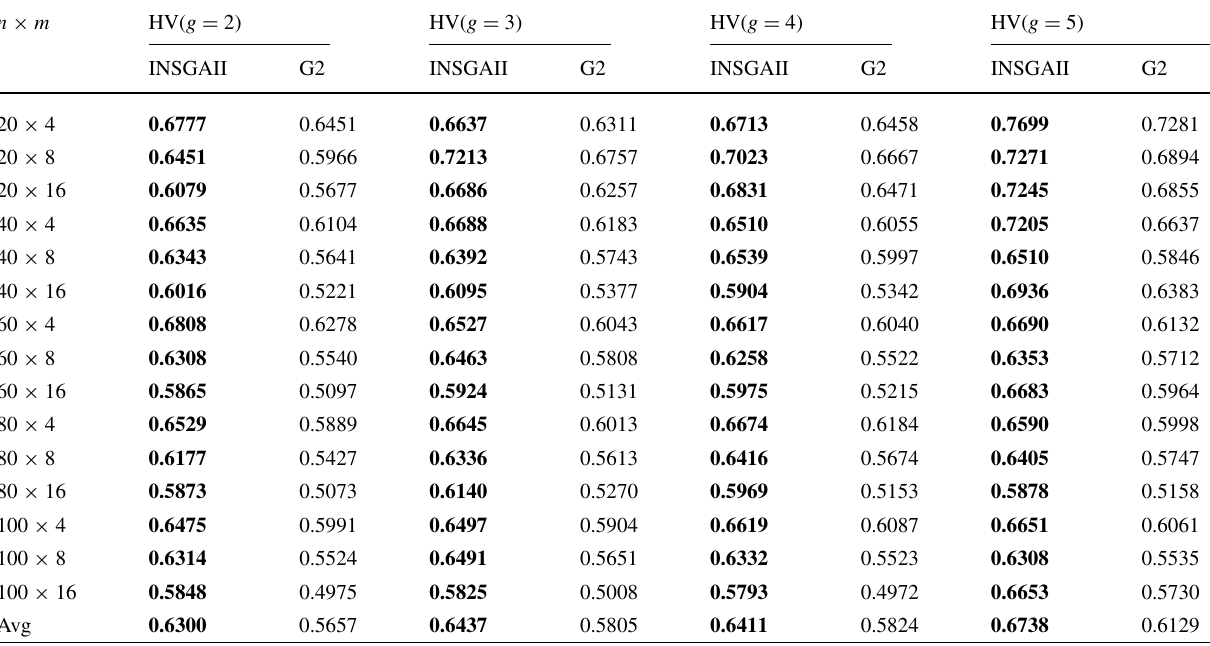
Table 6 Comparisons of the HV values between INSGAII and G2 n × m